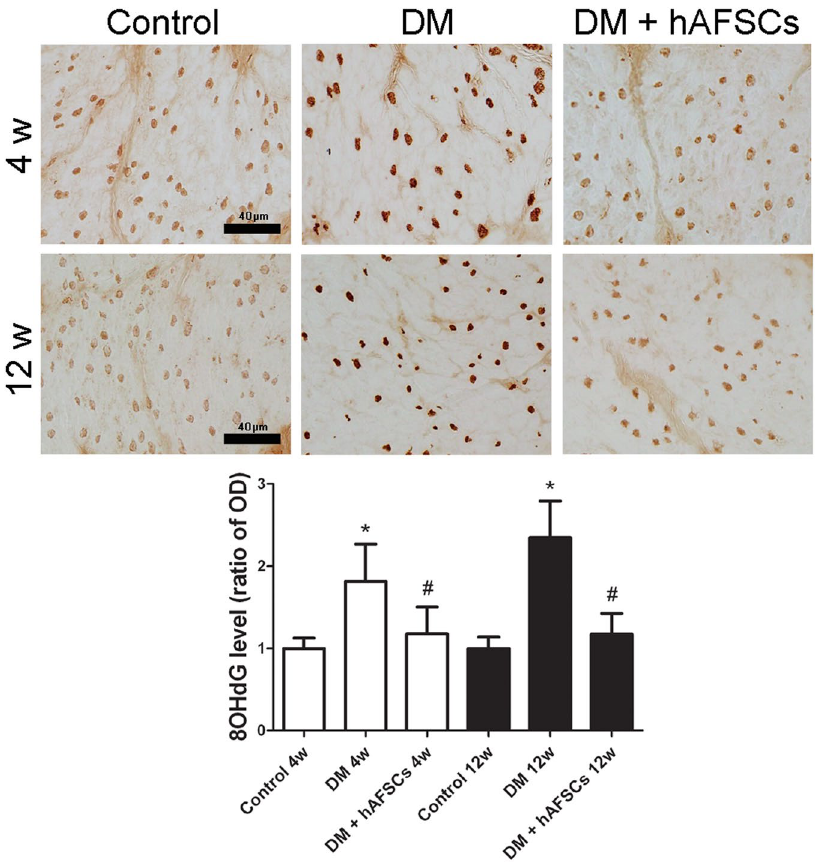
Figure 7. Temporal expressions of 8-hydroxy-20-deoxyguanosine (8OHdG) immunoreactivity in the bladder of control, STZ-induced diabetic rats (DM) and diabetic rats + hAFSCs transplantation (DM + hAFSCs). The immunoreactivity of 8OHdG can be seen in control rats ( A ), diabetic rats ( B ), and diabetic rats + hAFSCs transplantation ( C ) at 4 weeks, and in control rats ( D ), diabetic rats ( E ), and diabetic rats + hAFSCs transplantation ( F ) at 12 weeks. When compared to the controls, the expressions of 8OHdG in the diabetic bladder are increased at 4 and 12 weeks, but can be recovered to near the control level after hAFSCs transplantation. OD = optical density. Bar indicates 40 μ m. * P < 0.05 vs. control group. # P < 0.05 vs. diabetic rat. N = 10 in each time